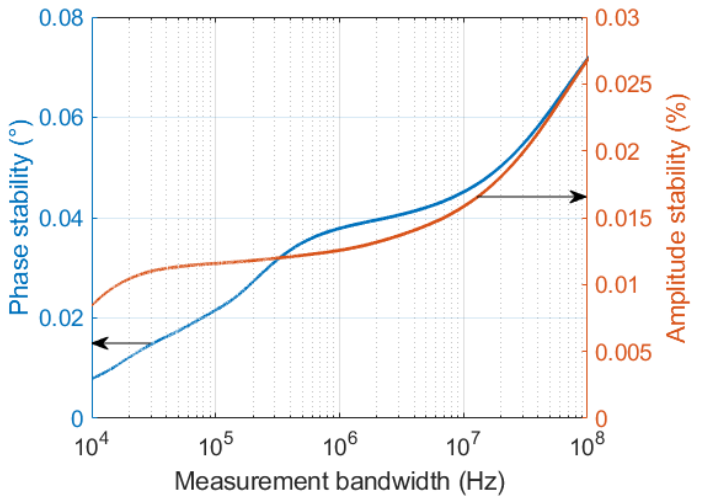
Figure 11. Measured phase and amplitude stability across different measurement